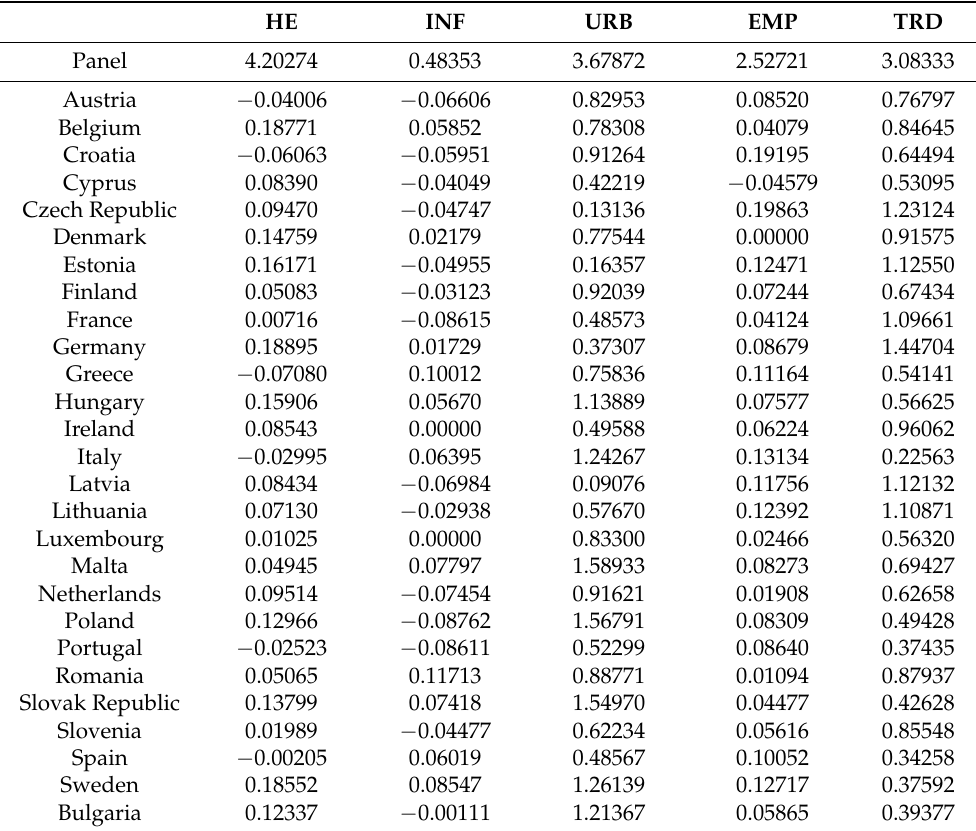
Table 5. Random Forest Test